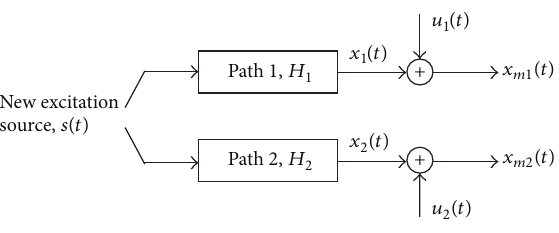
Figure 2: Single input-two-output model for a new excitation source.